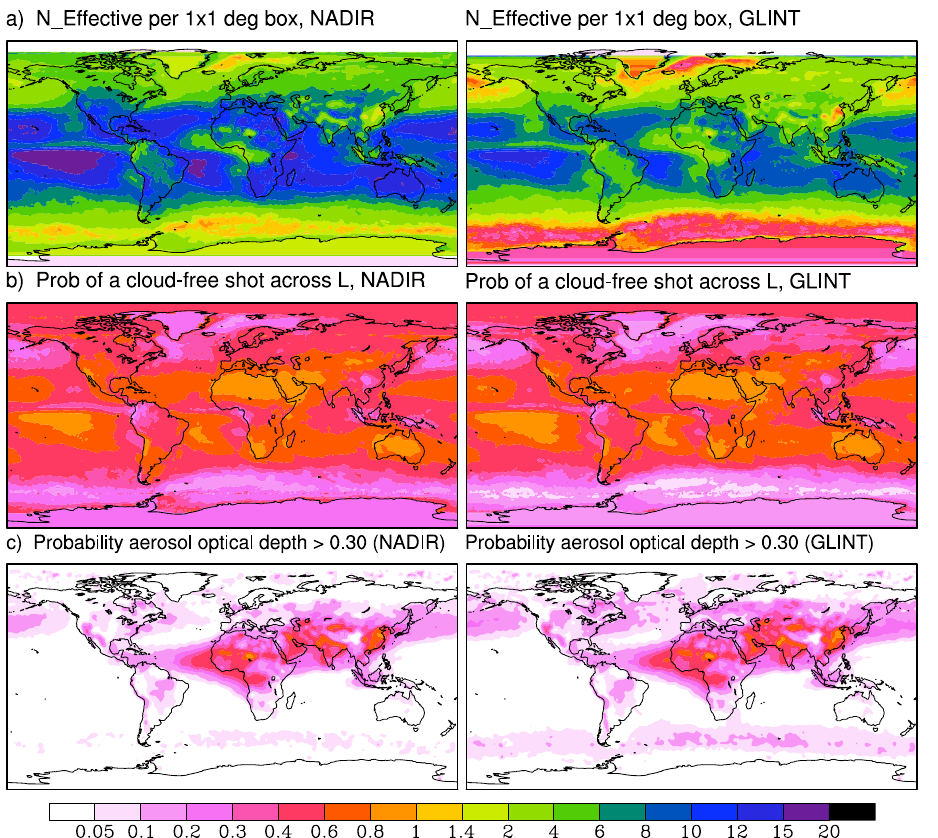
Fig. 7. (a) The effective number of independent X CO measurements N eff in each 1 ◦ latitude band for a single sun-lit pass of the OCO 2 orbit for both nadir (left) and glint (right), computed with Eq. (2). (b) The probability P cloud − free of finding at least one cloud-free X CO measurement across an OCO FOV ground track of length L (Fig. 5b), calculated from MODIS data according to the procedure outlined